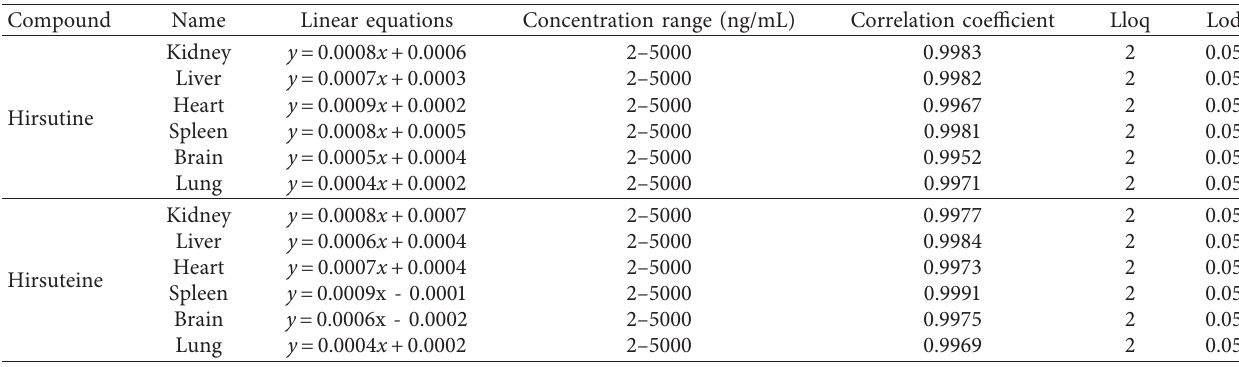
Table 1: Linear equations, correlation coefficients, lower limit of quantification, and detection limit of hirsutine and hirsuteine in mouse tissue.